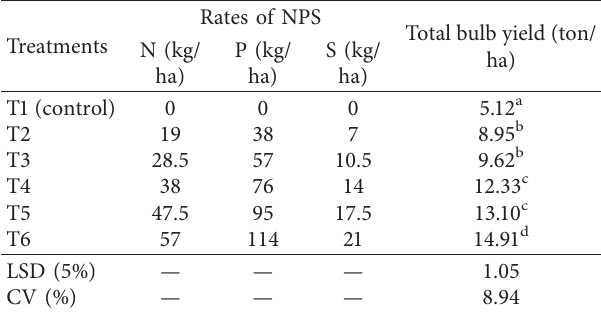
∗ Means followed by the same letter are not significantly different at 5% level of significance.